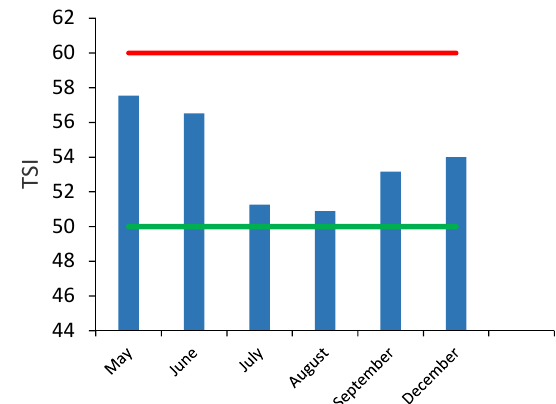
Fig. 6: Temporal distribution of the total TSI index in different months (between red and green lines = upper-mesotrophic area)